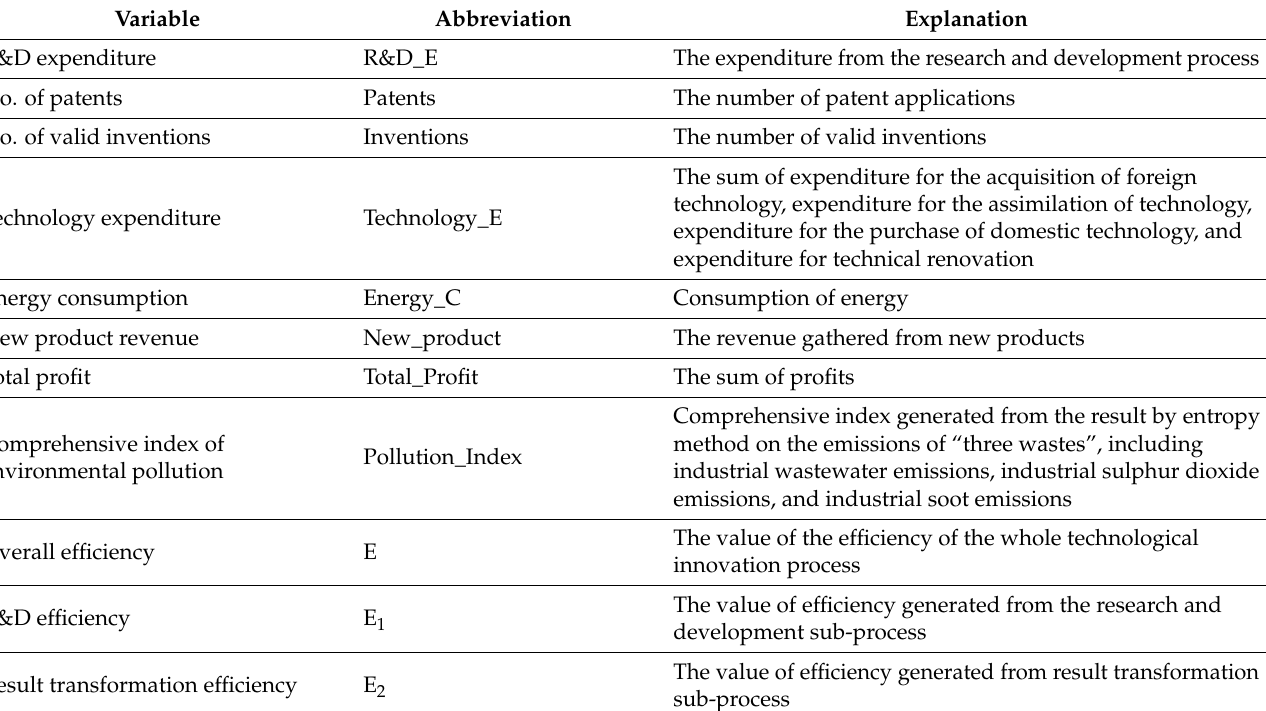
Table 2. The Definition of Different Variables of the Green Technology Innovation